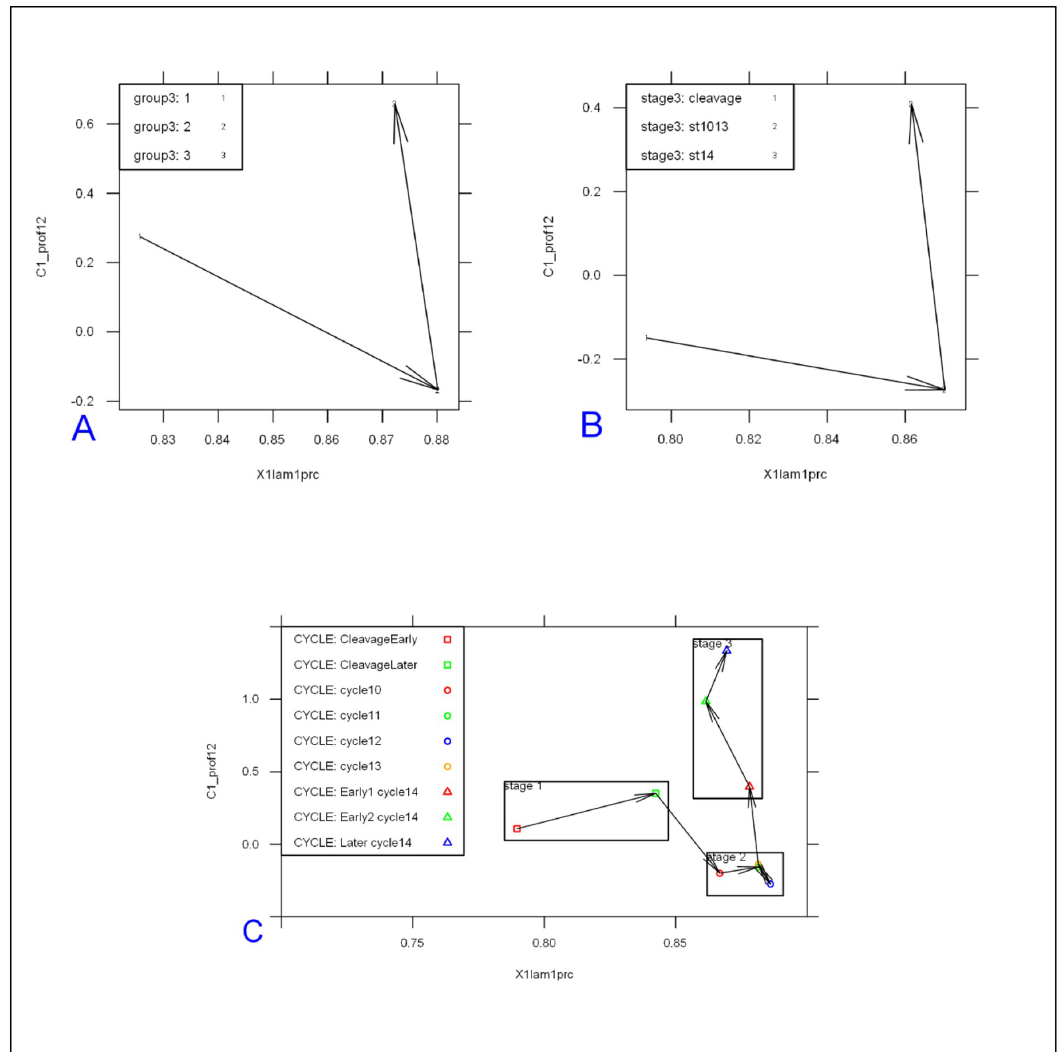
Fig 4. The change in two-exponential model parameters in time is similar for bcd mRNA (A) and Stau (B): Mean values of � � , showing distinct developmental trajectories. Means are significantly different for the 3 main l apical ð Þ anterior groups shown. (C) bcd mRNA data over nine age